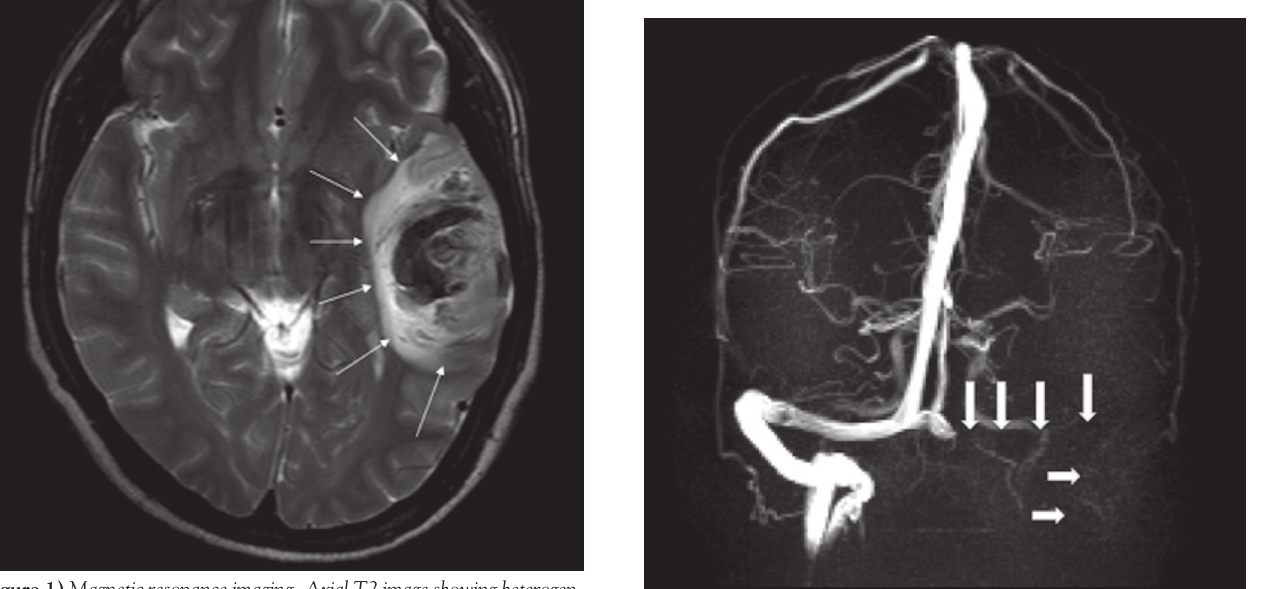
Figure 2) Magnetic resonance venogram image showing abrupt loss of flow related signal at the proximal left transverse sinus continuing distally to involve the left sigmoid sinus, vein of Labe and jugular vein